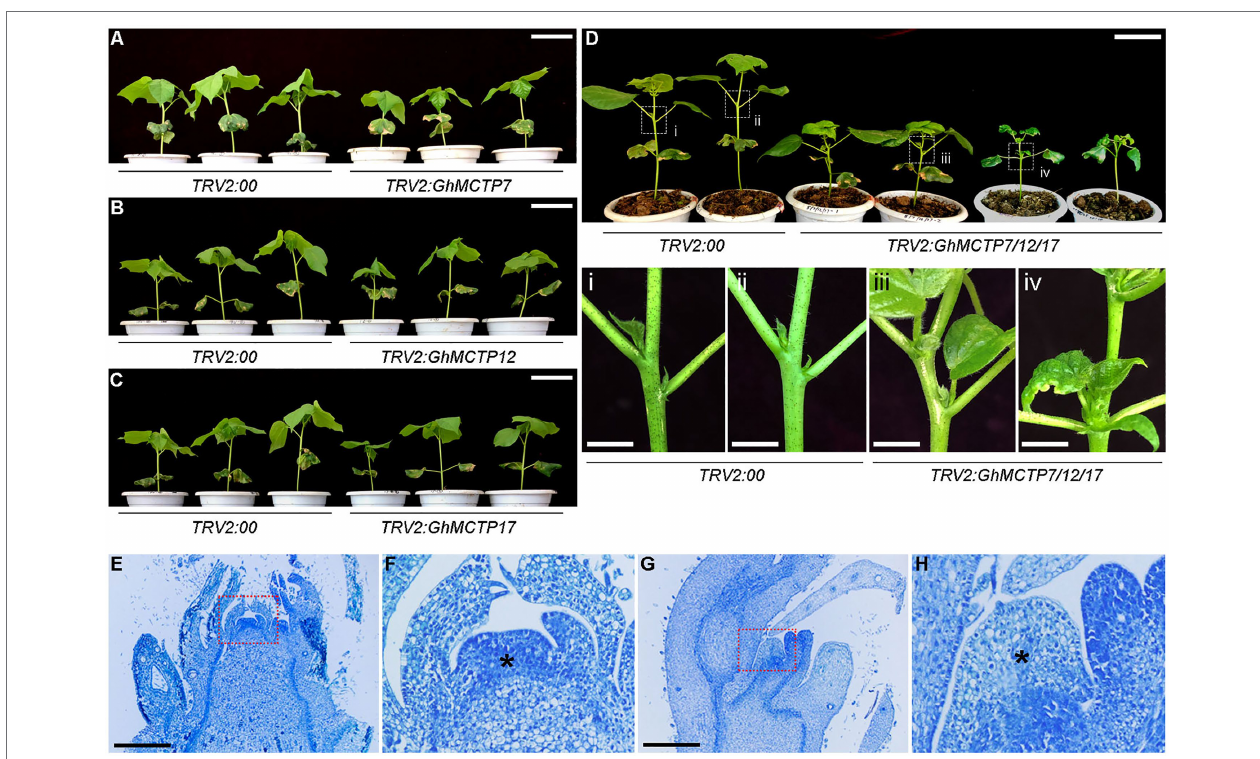
FIGURE 5 | Phenotypic analyses of TRV2:GhMCTPs plants. (A–C) Plant height comparison of 3–4 leaf stage TRV2:GhMCTP7 (A) , TRV2:GhMCTP12 (B) , and TRV2:GhMCTP17 (C) plants with TRV2:00 plants (negative control group). Scale bars = 5 cm. (D) Plant height comparison of four leaf stage TRV2:GhMCTP7/12/17 with TRV2:00 plants (upper panel). The lower panels show the magnified view of boxes indicated in the upper panel. Scale bars = 5 cm (top) and 1 cm (bottom). (E–H) Median longitudinal section of main inflorescence shoot apices of TRV2:00 (E) and TRV2:GhMCTP7/12/17 (G) plants. Scale bars = 1 μ m. (F,H) The magnified views of boxes are indicated in (G) and (H) , respectively. Asterisks indicate main inflorescence